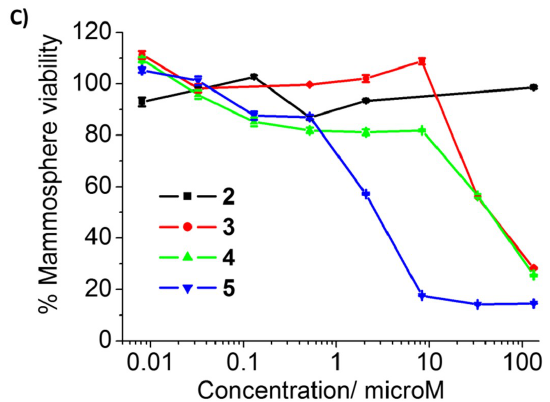
Figure 2. ( A ) Representation of the number of mammospheres formed from HMLER-shEcad cell suspensions treated with 2 – 5 or salinomycin for 5 days at their respective IC 20 values. Standard deviation was used to calculate the associated errors. ( B ) Bright-field images (taken using an inverted microscope) representative of untreated HMLER-shEcad mammospheres and those treated with 2 – 5 or salinomycin for 5 days at their respective IC 20 values (×20 magnification). ( C ) Compound concentration versus percentage mammosphere viability plots for 2 – 5 against HMLER-shEcad mammospheres (5 days incubation).